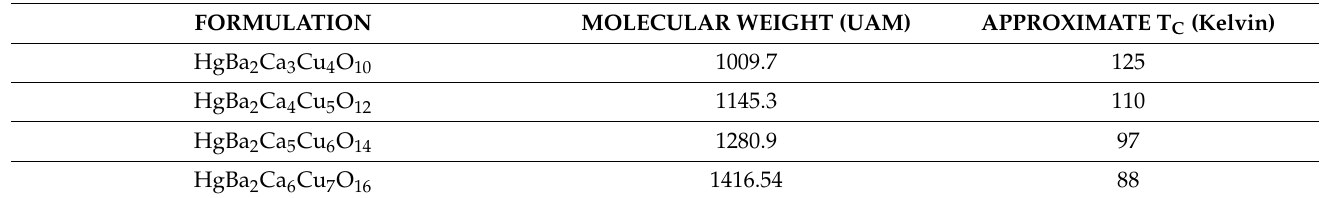
Table 1. Cont. NUMERICAL OPTIMIZATION DATA FOR